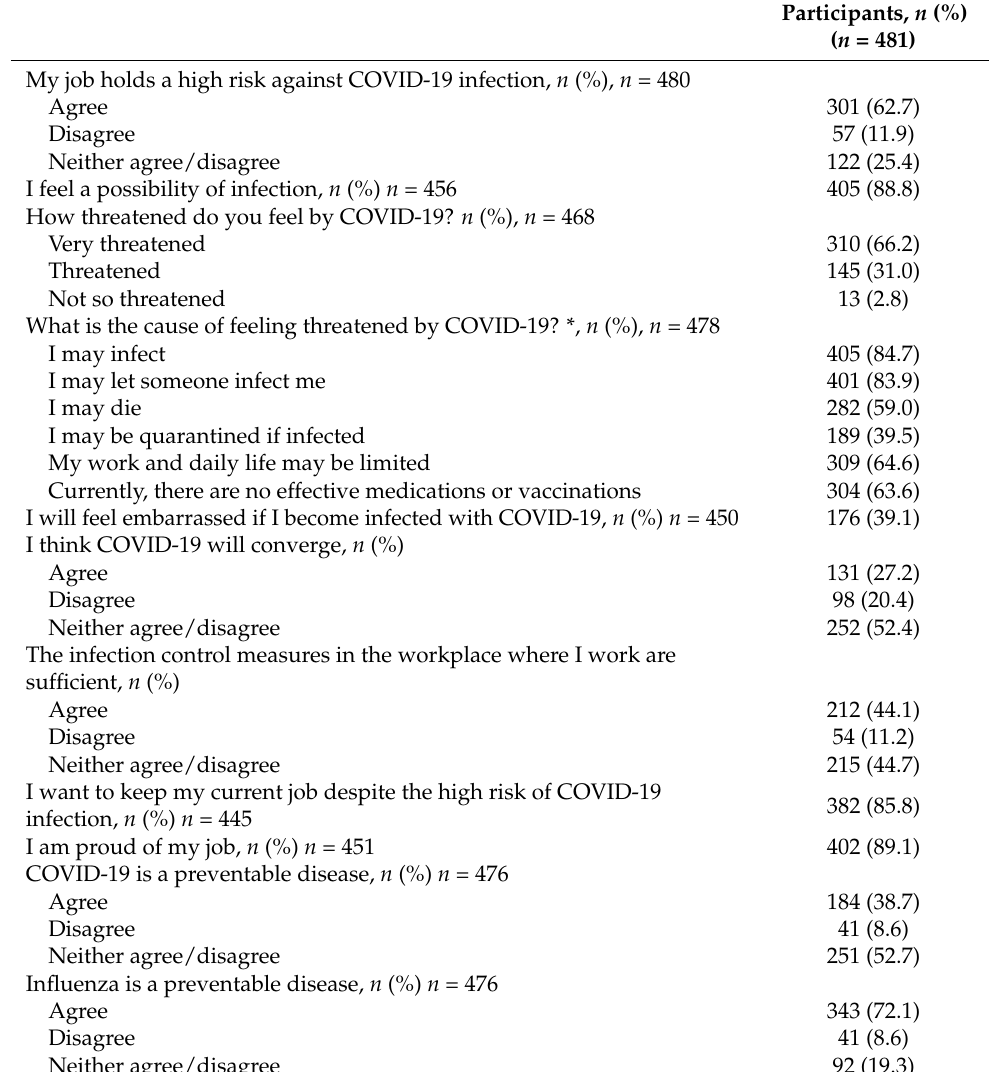
Table 3. Attitudes relating to COVID-19 among nursing care